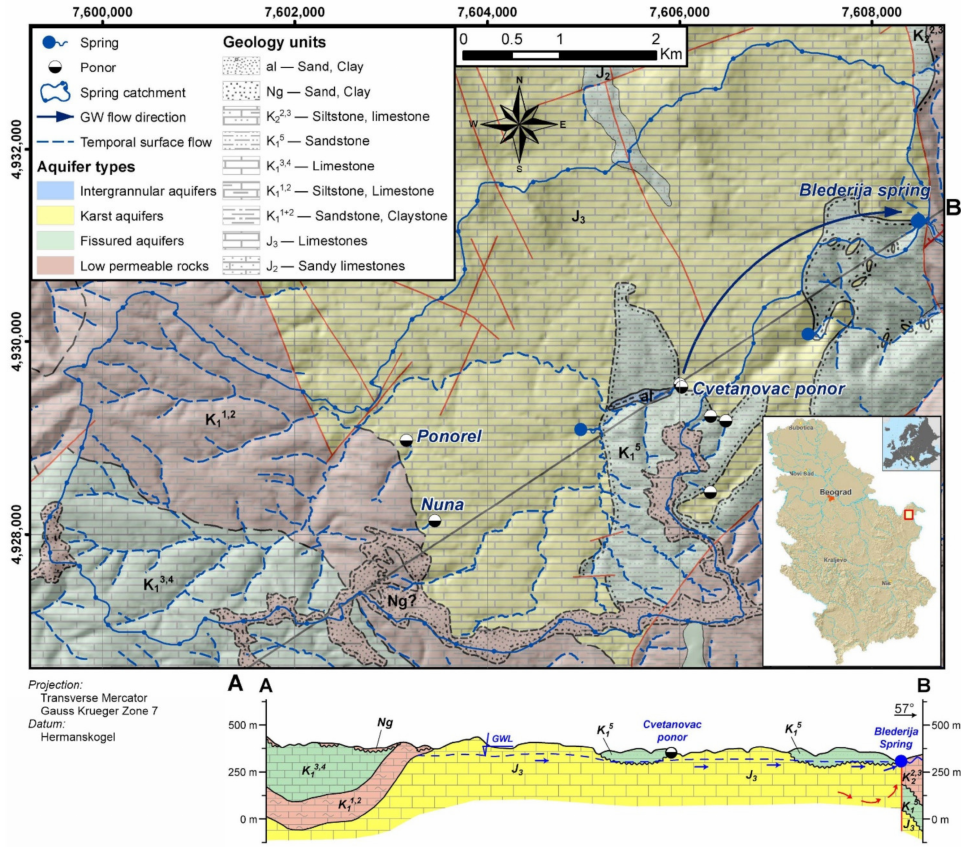
Figure 2. Hydrogeology map and vertical hydrogeological section A − B of the Blederija Spring catchment area ([33],